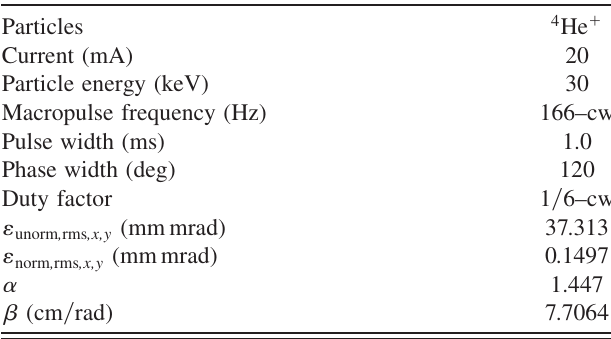
TABLE I. Parameters of the helium injector for the coupled RFQ-SFRFQ cavity.